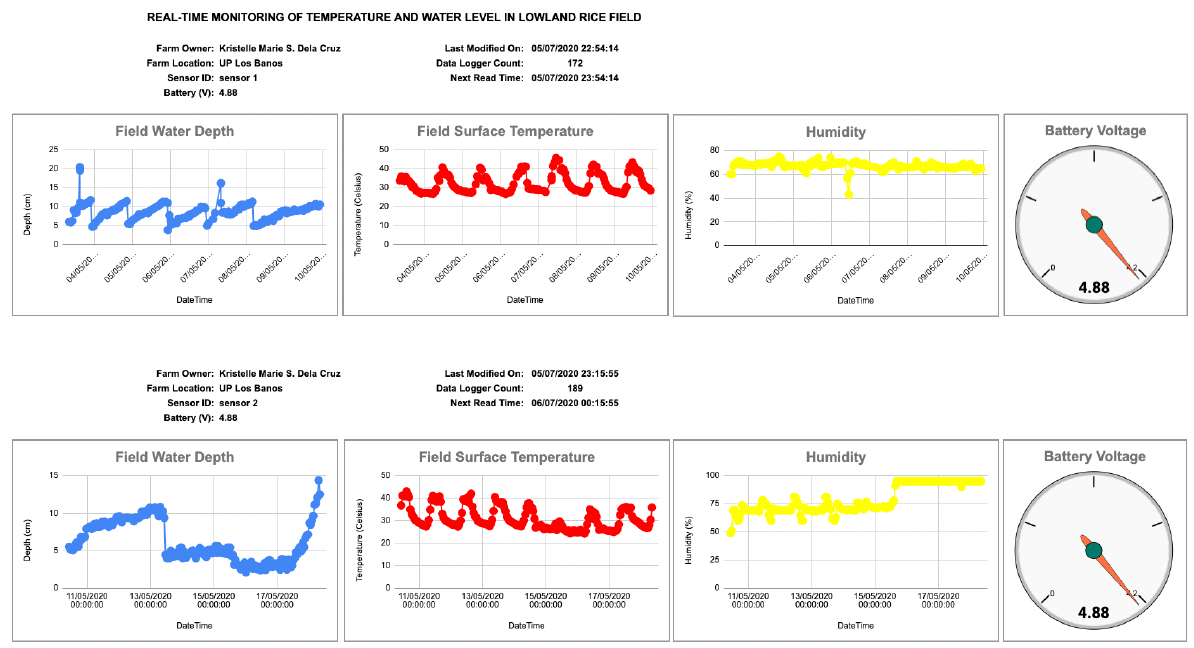
Figure 5. Dashboard of the online database showing real-time data of water level, surface temperature, and humidity, as well as the battery voltage of the low-cost sensor.